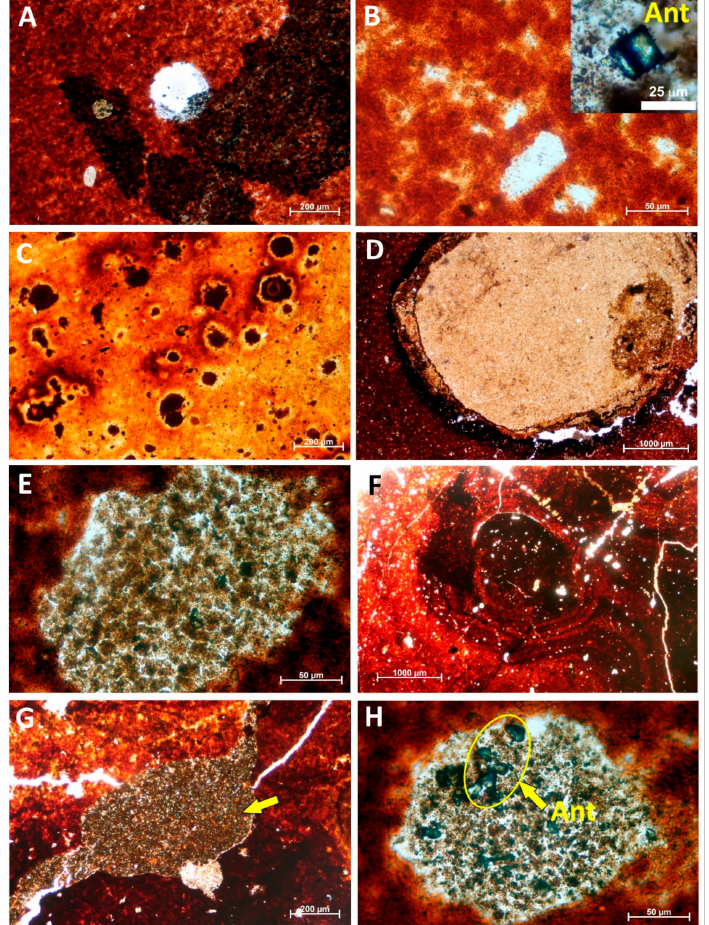
Figure 2. Microphotographs of the Toši´ci-Duji´ci bauxite samples: ( A )—anhedral to globular gibbsite in pseudoporphyritic structure of TOS-1-D; ( B )—anhedral to subhedral gibbsite grains in micro- granular texture of TOS-1-S, and euhedral anatase (inset); ( C )—panidiomorphic to granular texture with spherical hematite in TOS-1-G; ( D )—a pisoid in TOS-2 with gibbsitic core and hematitic rim; ( E )—gibbsite grain including hematite and anatase grains in TOS-2; ( F )—broken hematitic pisoid in TOS-3 implying redeposition; ( G )—a crevice in TOS-3 filled with detrital material (marked by yellow arrow); ( H )—nodule-like gibbsite including tiny hematite and anatase grains in TOS-4 (anatase grains in ellipse and pointed out by the